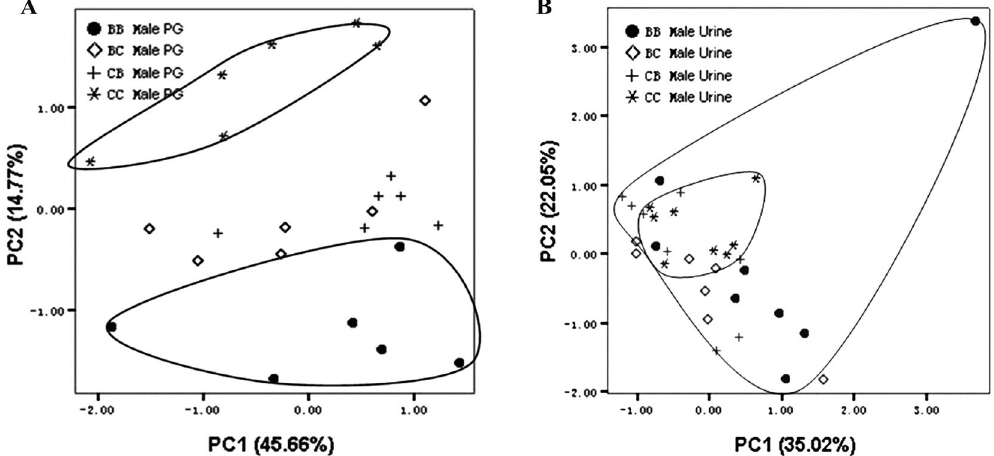
Figure 2. Principle component analysis of PGS ( A ) and urine ( B ) data. Each sample is represented by the initial letters of the strain name; n = 6 in each group. BB: BALB/c strain; CC: C57BL/6 strain; BC: hybrid of